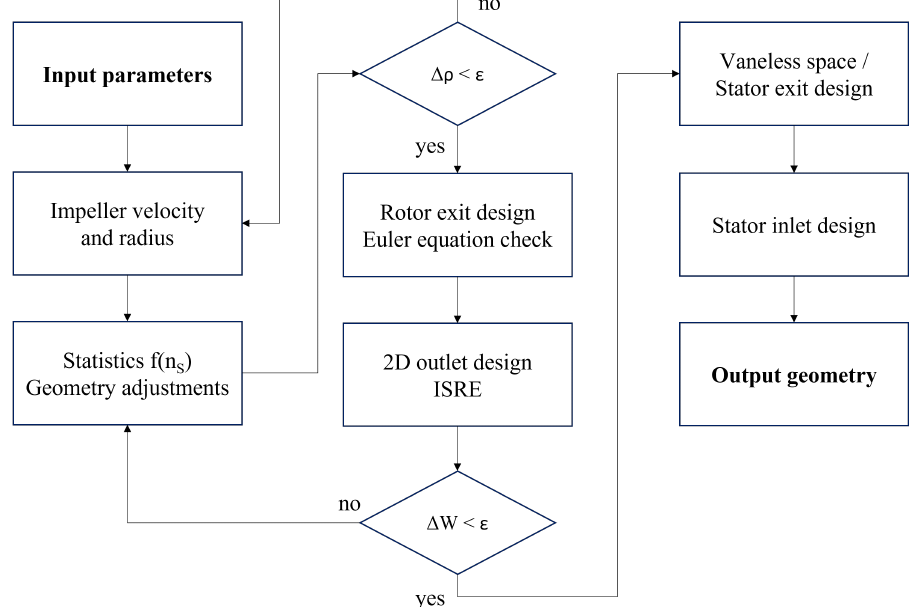
Figure 4. Centripetal turbine 1D design